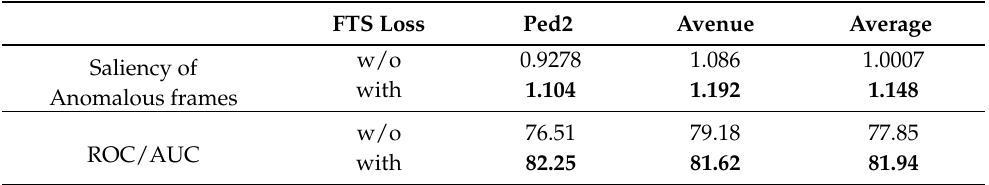
Table 5. Saliency and ROC/AUC of the LSTM model with or without applying FTS loss. The bold font represent saliency of anomalous frames and ROC/AUC performances utilizing the FTS loss. FTS Loss